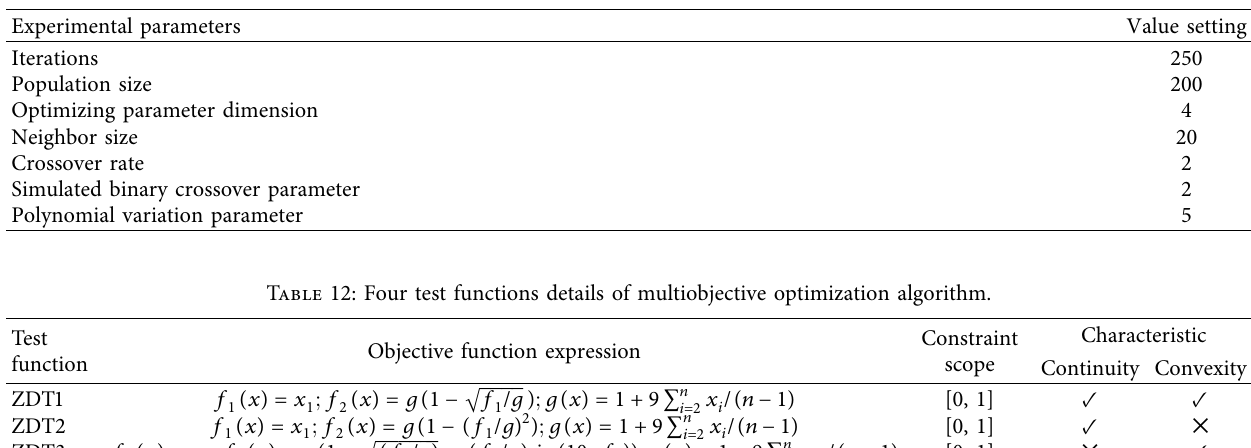
Table 11: Parameter default settings of MOEA/D.